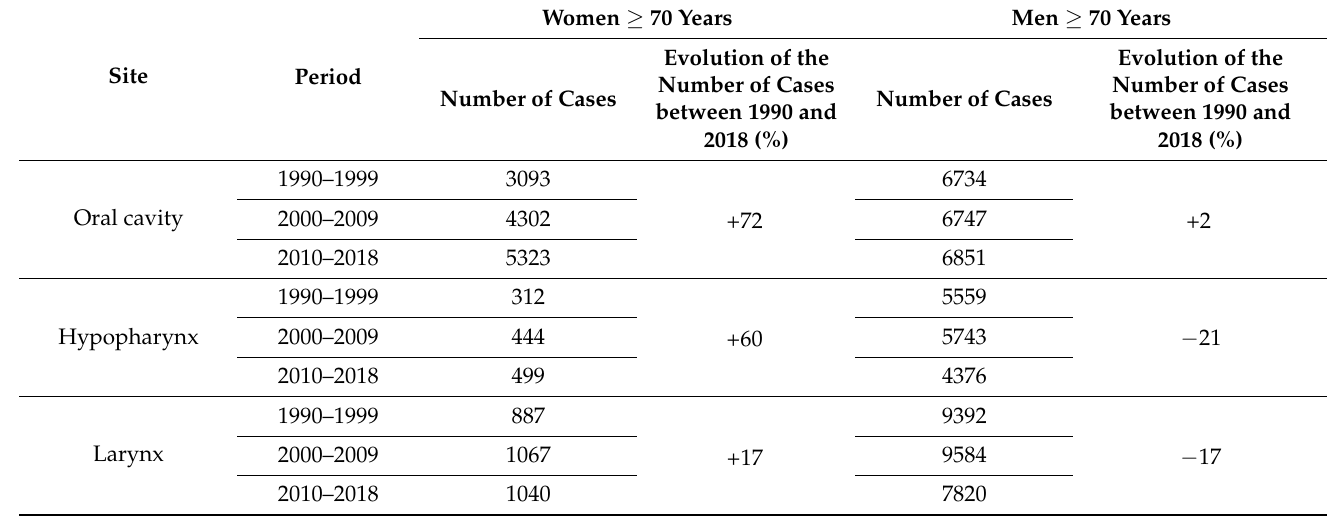
Table 1. Evolution of the number of cases of oral cavity, hypopharynx, and larynx cancers by sex, among patients aged 70 years or more between 1990 and